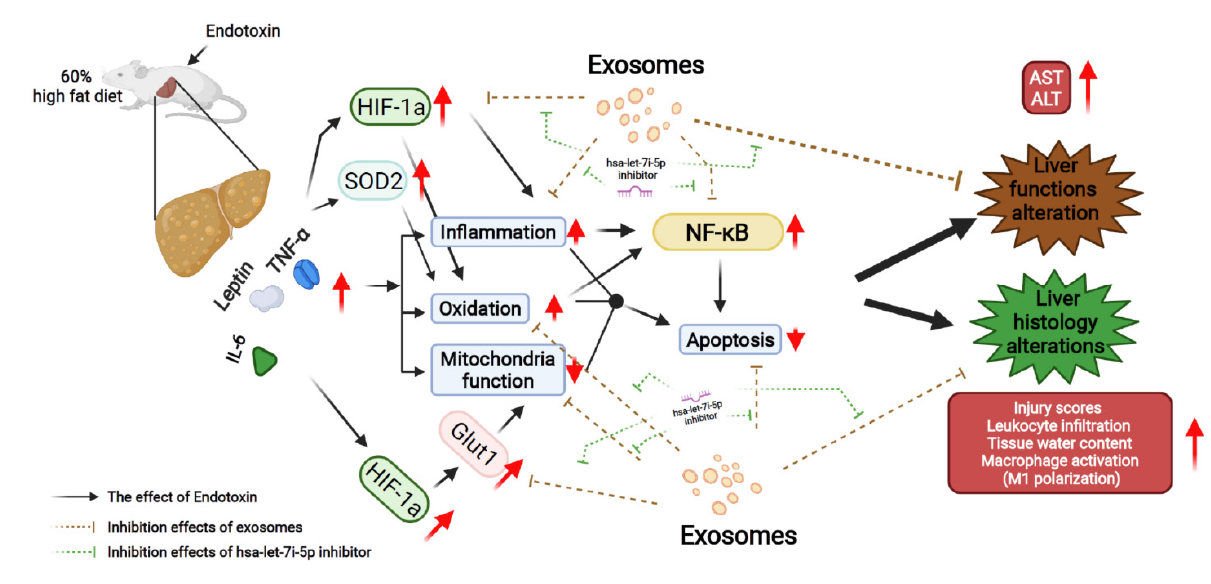
Figure 7. Diagram illustrating the effects and mechanisms of exosomes (from human placenta choriodecidual membrane-derived mesenchymal stem cells, pcMSCs) in inhibiting liver injury in endotoxin-treated high-fat diet obese mice, measured at 48 h after the intraperitoneal administration of endotoxin. The effects of inhibiting hsa-let-7i-5p microRNA on offsetting the effects of exosomes are also illustrated. ALT: alanine aminotransferase. AST: aspartate aminotransferase. GLUT1: